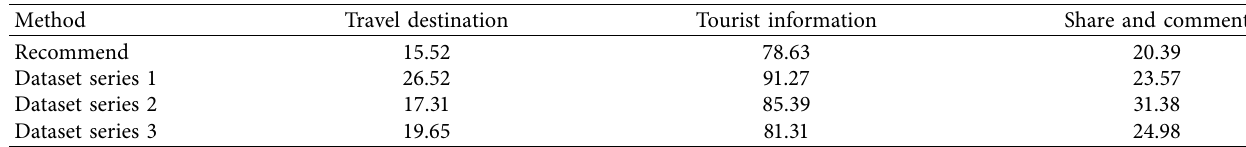
Table 3: Comparison of running time of different algorithms on